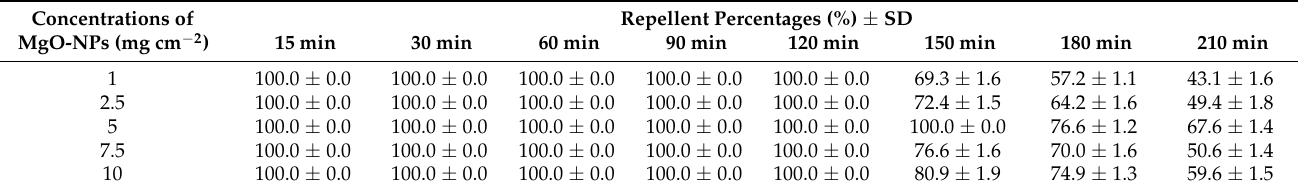
Table 2. The repellent assay of different concentrations of biosynthesized MgO-NPs against A. stephensi. Concentrations of MgO-NPs (mg cm − 2